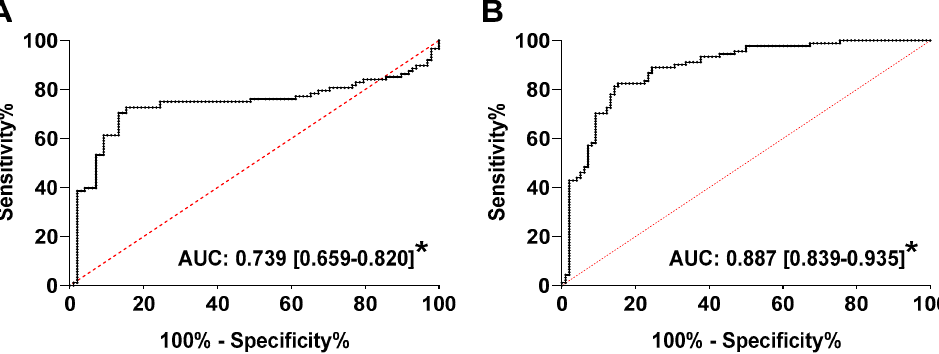
Figure 2. Receiver-operating characteristic (ROC) curves for total cell-free DNA (cfDNA) concentration in plasma of women with gestational hypertension (GH, A ) or preeclampsia (PE, B ) compared to women with healthy pregnancies (HP). Values are area under the curve (AUC) {95% confidence interval}. * p < 0.0001 versus HP group.